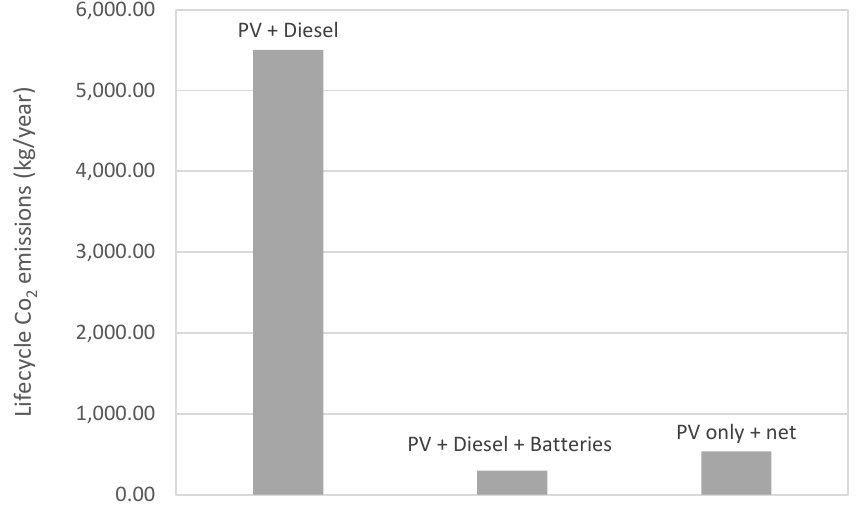
Figure 14. Lifecycle CO 2 emissions of the different schemes. All the cases represented.